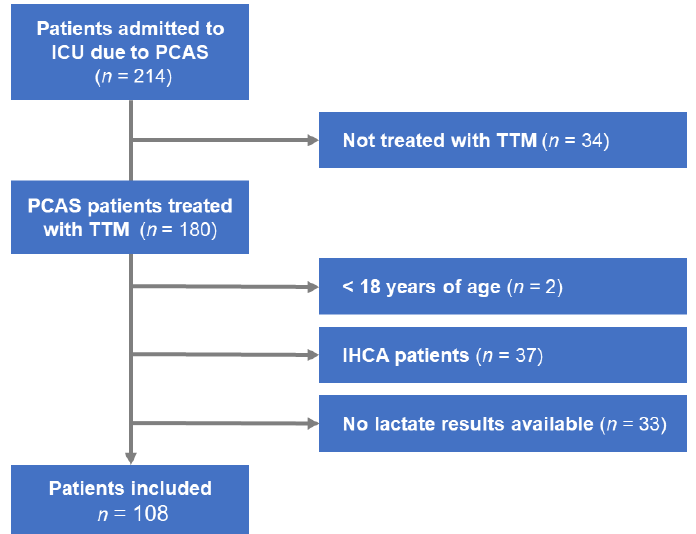
Figure 1. Patient enrollment flow diagram. ICU: intensive care unit, IHCA: in-hospital cardiac arrest, PCAS: post-cardiac arrest syndrome, TTM: targeted temperature management.